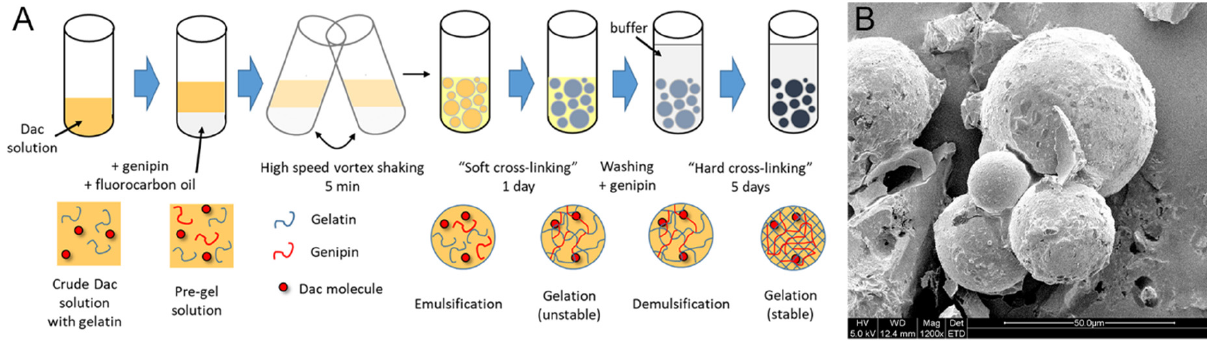
Figure 1. Fabrication of two-step cross-linked hydrogel for Dac immobilization. ( A ) Procedure of two-step cross-linked hydrogel. ( B ) Scanning electron microscope (SEM) image of hydrogel particles with a magnification scale of 1200 ×